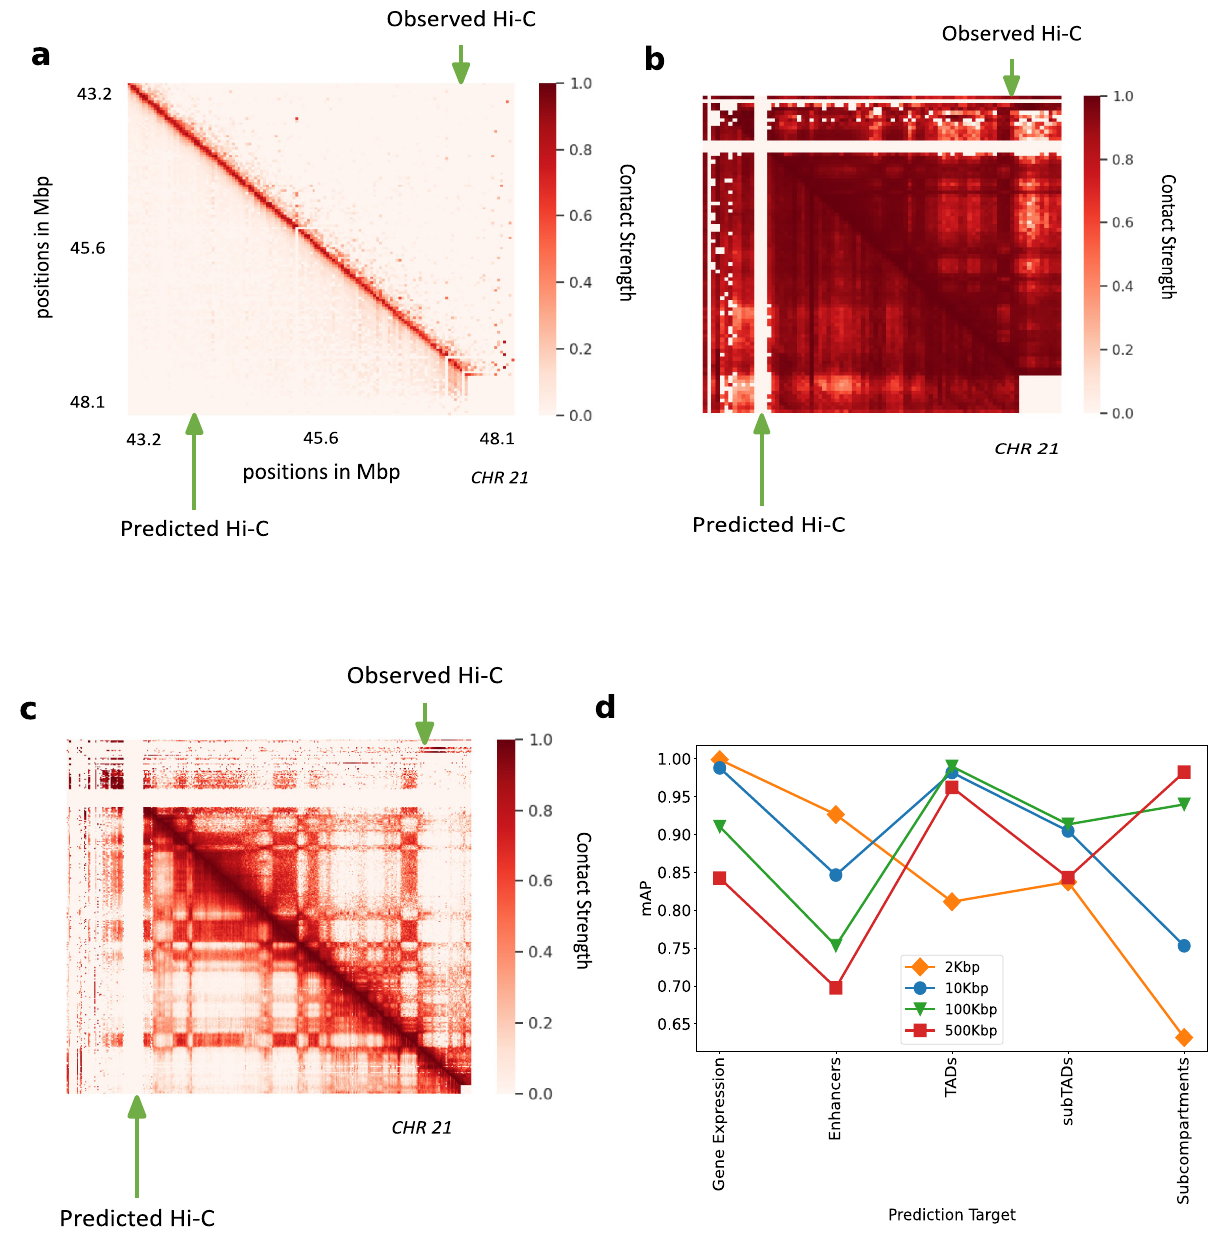
Fig. 5 Hi-C-LSTM applied at different resolutions. a Hi-C-LSTM predictions at 2 kbp resolution. A selected portion of the observed Hi-C map (upper- triangle) and the predicted Hi-C map (lower-triangle) in GM12878. The portion is selected from chromosome 21, between 43.2 and 48.1 Mbp. b Hi-C- LSTM predictions at 500Kbp resolution. The observed Hi-C map (upper-triangle) and the predicted Hi-C map (lower-triangle) in GM12878 for chromosome 21. c Hi-C-LSTM predictions at 100 kbp resolution. The observed Hi-C map (upper-triangle) and the predicted Hi-C map (lower-triangle) in GM12878 for chromosome 21. d The classi fi cation performance (as measured in mAP) with gene expression, enhancers, TADs, subTADs, and subcompartments of models trained at different